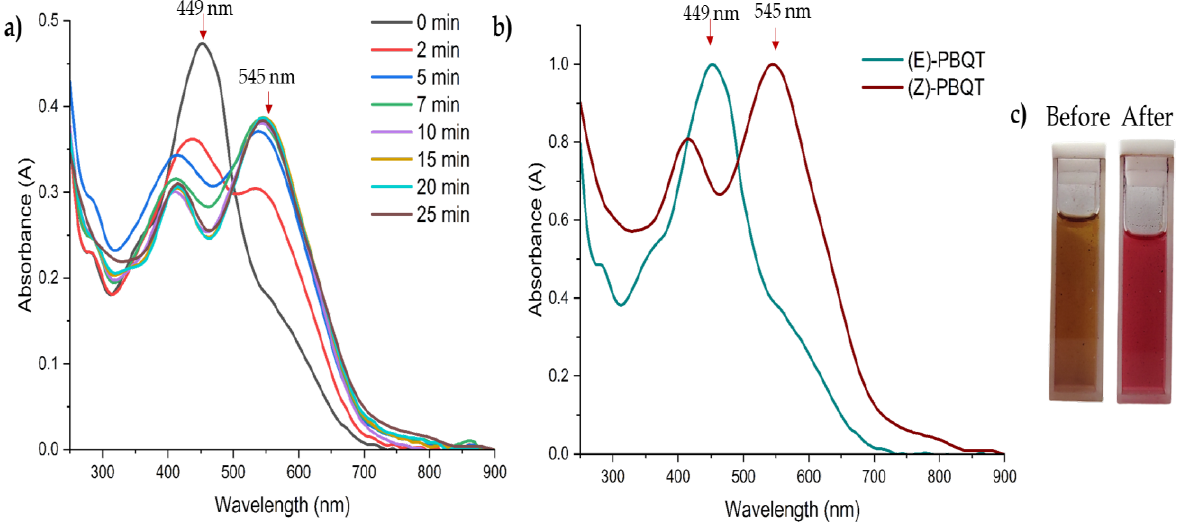
Figure 5. ( a ) Absorption spectra of PBQT in chloroform at different irradiation times; as the irradi- ation time increases, a bathochromic shift in the absorption of PBQT is observed. ( b ) Absorption spectra of PBQT in chloroform before and after irradiation; ( c ) PBQT solutions before being irradiated and in their final state after irradiation, an evident colorimetric change can be observed.